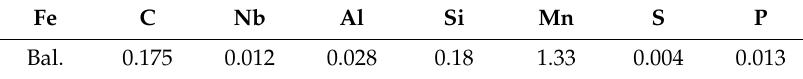
Table 2. Chemical composition of the E355 substrate material (in wt %).